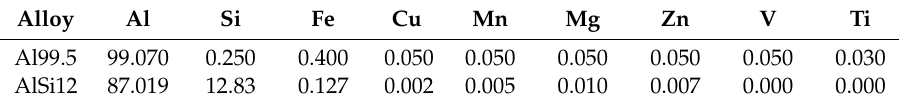
Table 1. Chemical composition of the matrices (in wt